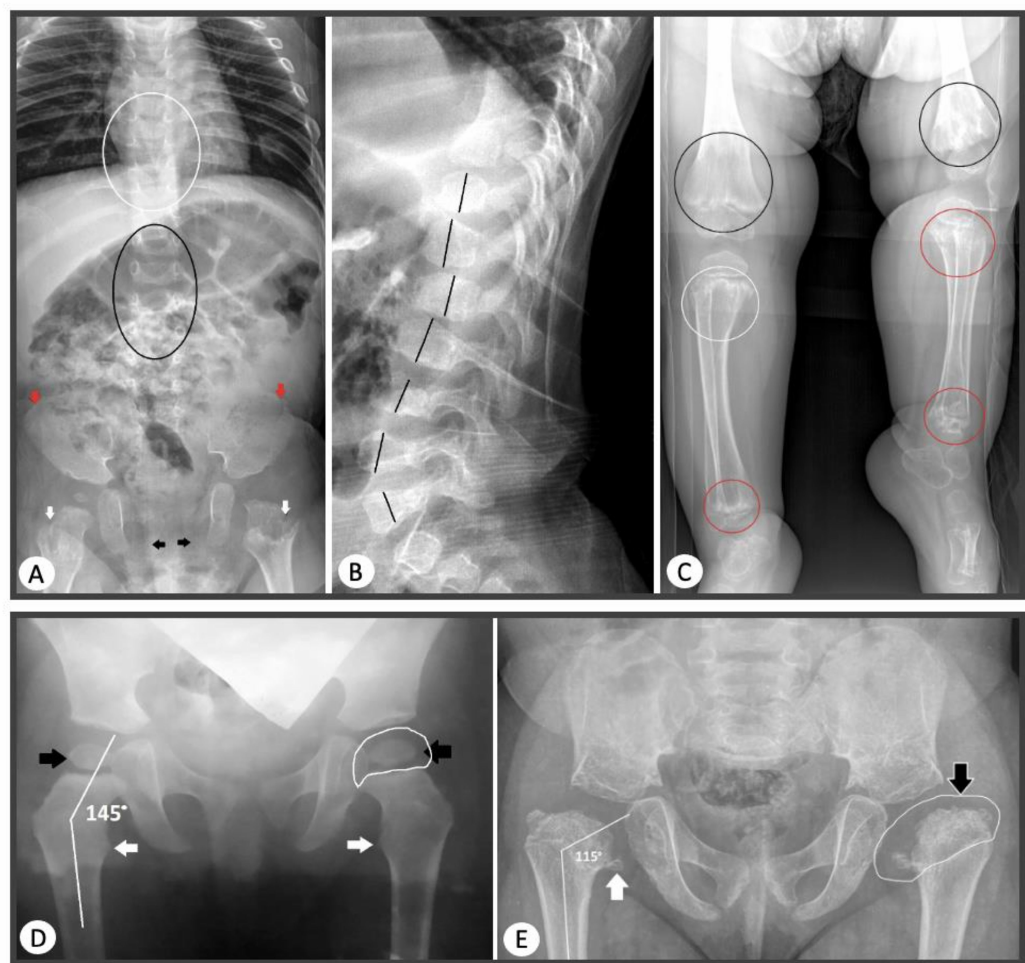
Figure 4. Radiological signs of COL2A1-skeletal dysplasia in probands from our sample. ( A ) AP radiograph of thoracolumbar spine, pelvis, and hips of the patient with dysspondyloenchondromato- sis. Anisospondyly and mild wedge-shape vertebral bodies of the thoracic (white circle) and lumbar (black circle) spine; lacy iliac crests (red arrows); deficient ossification of the pubic bones (black arrows); chondromatous lesions of the femoral necks (white arrows). ( B ) Lateral radiograph of thora- columbar spine of the patient with dysspondyloenchondromatosis. Anisospondyly of the thoracic and lumbar spine (the heights of the vertebral bodies marked with the black lines). ( C ) Radiograph of both legs of the patient with dysspondyloenchondromatosis. Extensive chondromatous lesions of the metaphyses of the distal femora (black circles), proximal (white circles), and distal (red circles) tibiae and fibulae; remarkable length discrepancy on the lower legs. ( D ) AP radiograph of the hips of the patient with mild phenotype. Coxa valga (neck-shaft angle 145 ◦ , normal length of the femoral necks), normal ossification of the femoral head and neck (black arrows), and lesser trochanter (white arrows); normal shape of the femoral head (white line depicts presumed contour of the cartilaginous femoral head). ( E ) AP radiograph of the hips of the patient with severe phenotype. Hypoplastic iliac wings, coxa vara et breva (neck-shaft angle 115 ◦ , short femoral neck), abnormal ossification of the femoral head and neck (black arrow), and lesser trochanter (white arrow); abnormal shape of the femoral head-coxa plana (white line depicts presumed contour of the cartilaginous femoral